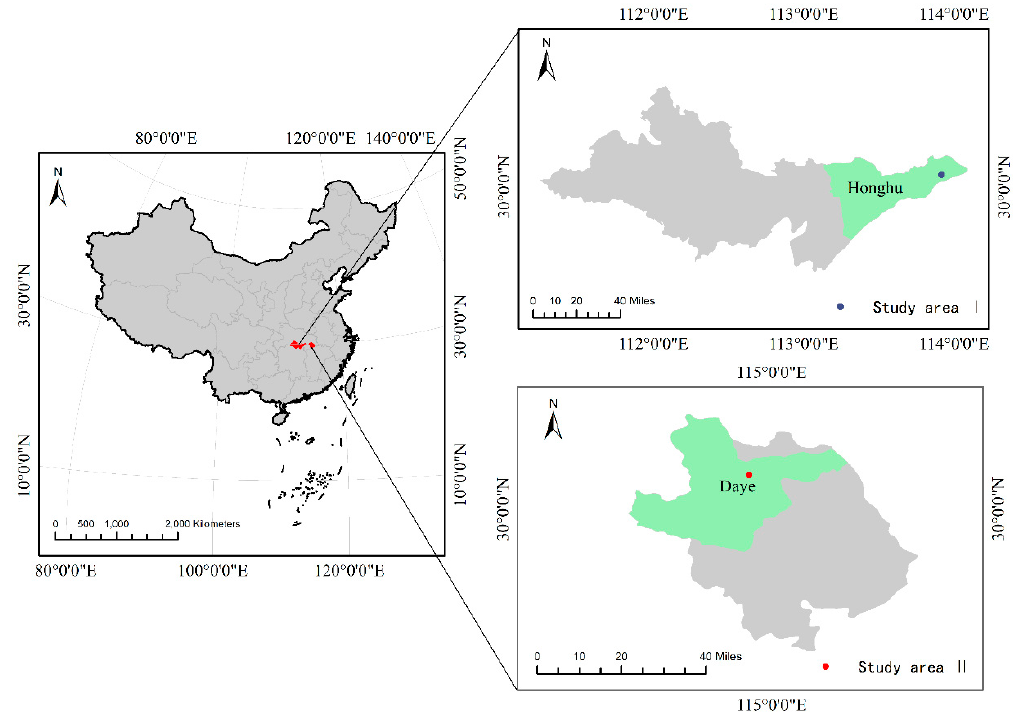
Figure 1. Study area locations.